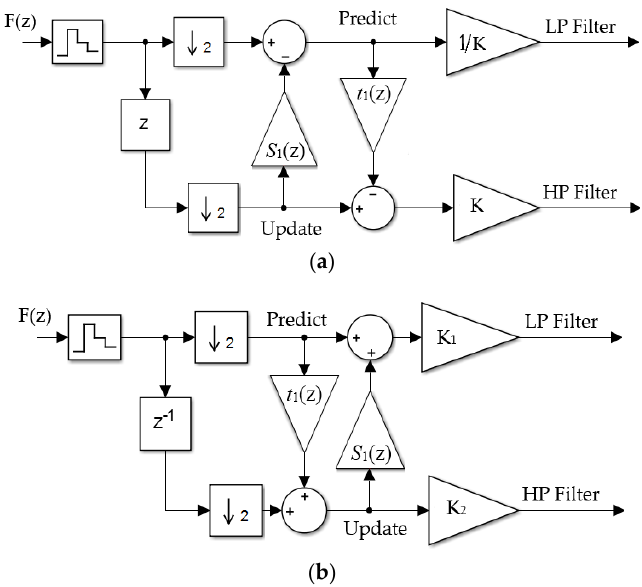
Figure 2. Schematics of lifting wavelet based on: ( a ) the first general structure; and ( b ) the second general